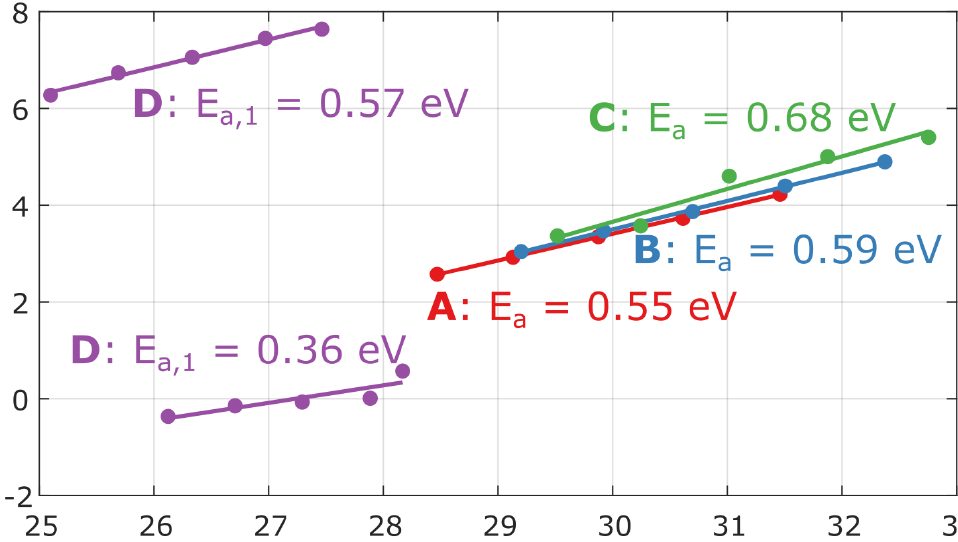
Figure 12. Comparison of the Arrhenius plots among the four technologies considered. Silicon Car- bide (SiC)-based devices ( A to C ) share a similar trapping signature and apparent activation energy, whereas the Si-based device ( D ) reveals a different behavior involving two trapping